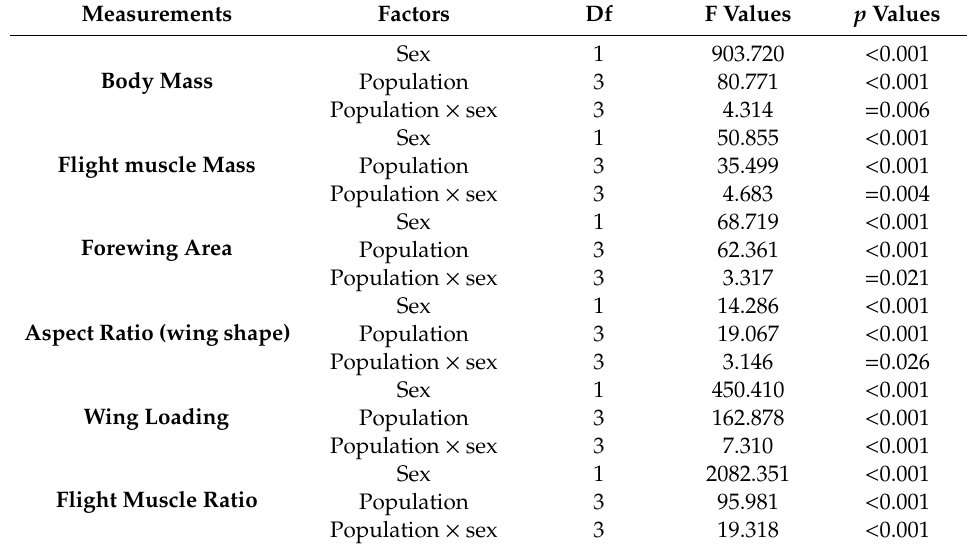
Table 2. Multi-way ANOVA tests of measurements of flight apparatus. The table shows the e ff ects of sex, population and their interaction (population × sex) on morphological measurements. The significance level is 0.05 (Tukey HSD post hoc